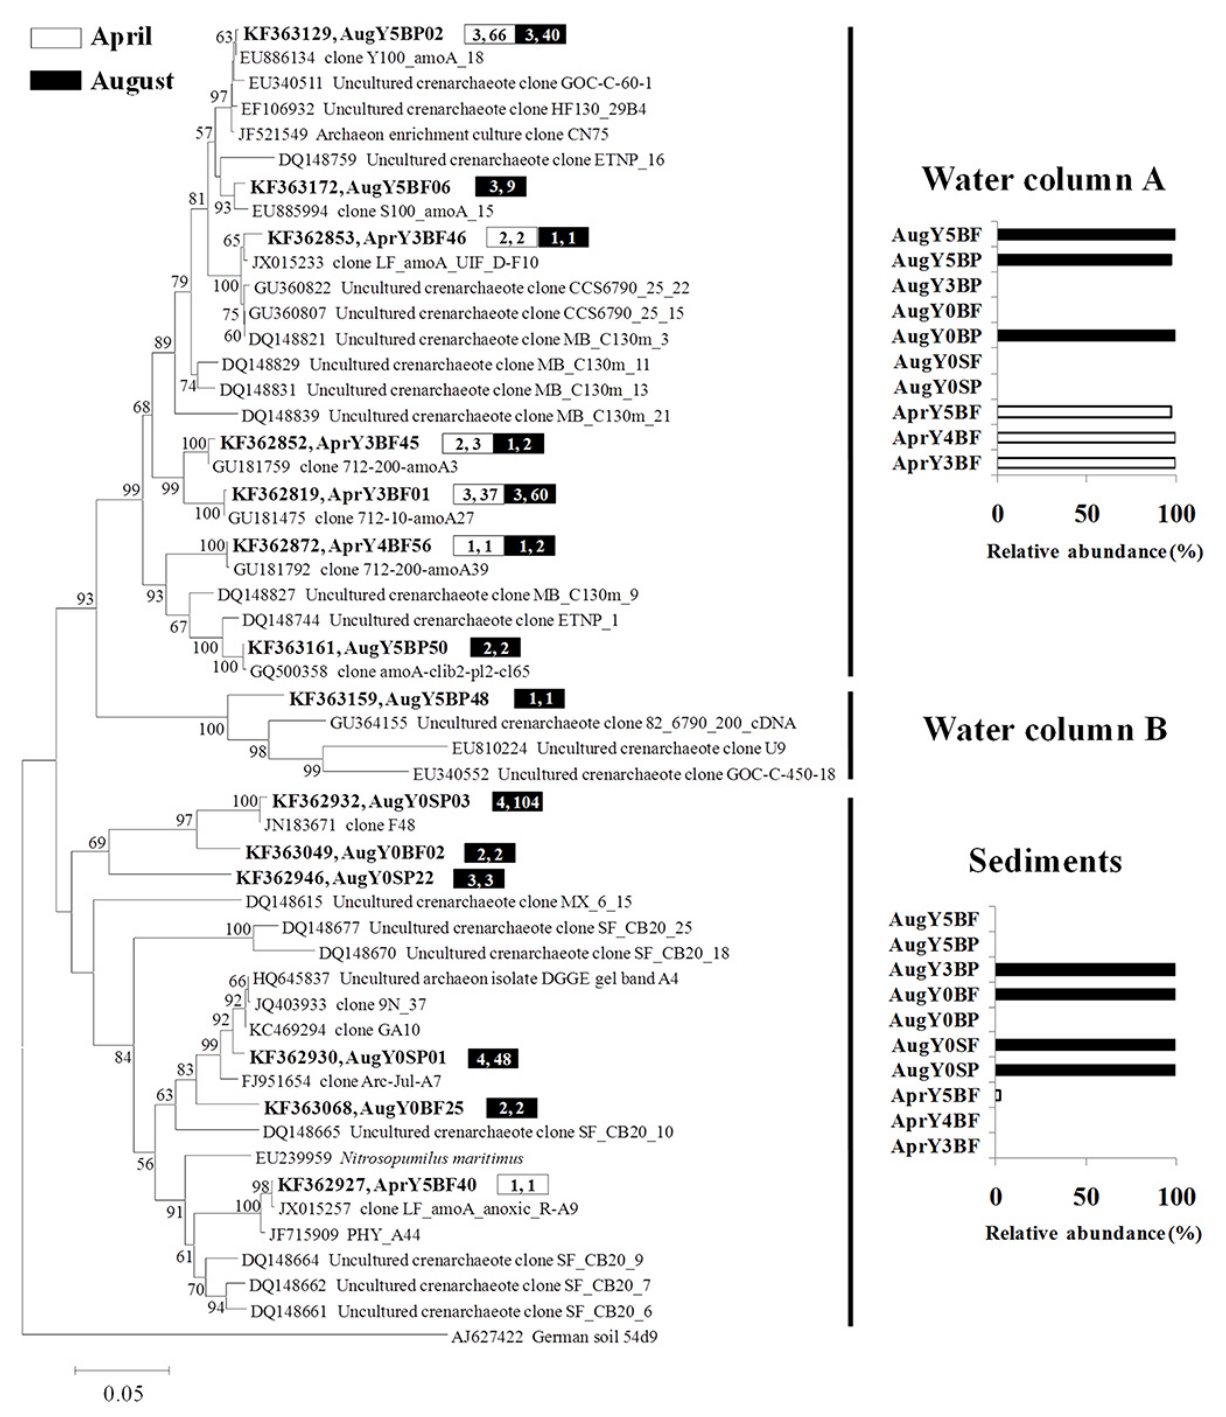
Fig. 4. Phylogenetic tree of AOA amoA constructed based on DNA sequences using the neighbor-joining method. Sequences from this study are shown in bold, and sequences sharing 95% DNA identity are grouped. In these groups, the number of samples and sequences is shown in the frame. The relative abundance of clones retrieved for each clone library in the three clusters is indicated by the bar. GenBank accession numbers are shown. Phylogenetic relationships were bootstrapped 1000 times, and bootstrap values greater than 50% were shown. Scale bar represents the nucleotide substitution